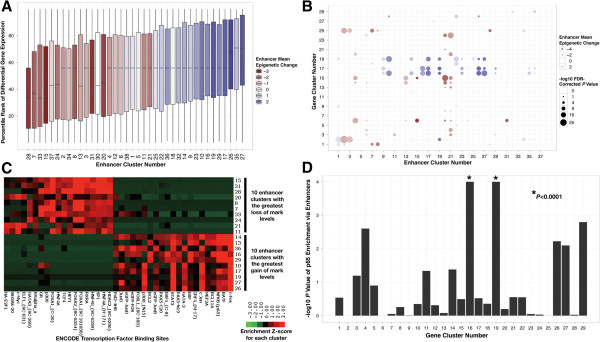
Activated and repressed enhancers associated with epithelial-mesenchymal transition-related gene clusters (EMT-GCs) and different sets of transcription factors. (A) Box plots of percentile ranks of differential expression for genes associated with each enhancer cluster. Boxes are colored by average magnitude of gain (blue) or loss (red) of enhancer-associated marks. (B) Overlap between gene clusters and genes linked to enhancer clusters. Bubbles are colored with respect to enhancers in the same manner as the boxes in panel A. Size of the bubbles represents the -log10 P value of the overlap. (C) Association of activated and repressed enhancer clusters with transcription factor binding sites. Significance of overlap between ENCODE transcription factor binding sites (columns) and the 10 enhancer clusters with the strongest activated signatures as well as the 10 equivalent repressed enhancer clusters (rows). Each spot on the heat map is the -log10 P value of the overlap, which is Z-score normalized by row. (D) Association of p65 binding sites with gene clusters via enhancers. Enrichment of p65 binding sites (ENCODE) in the enhancers assigned to each gene cluster.